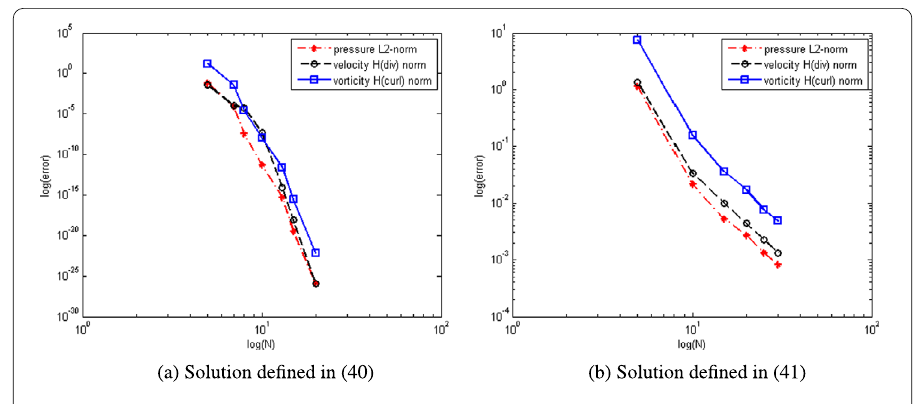
Figure 2 Error curves for the spectral discretization